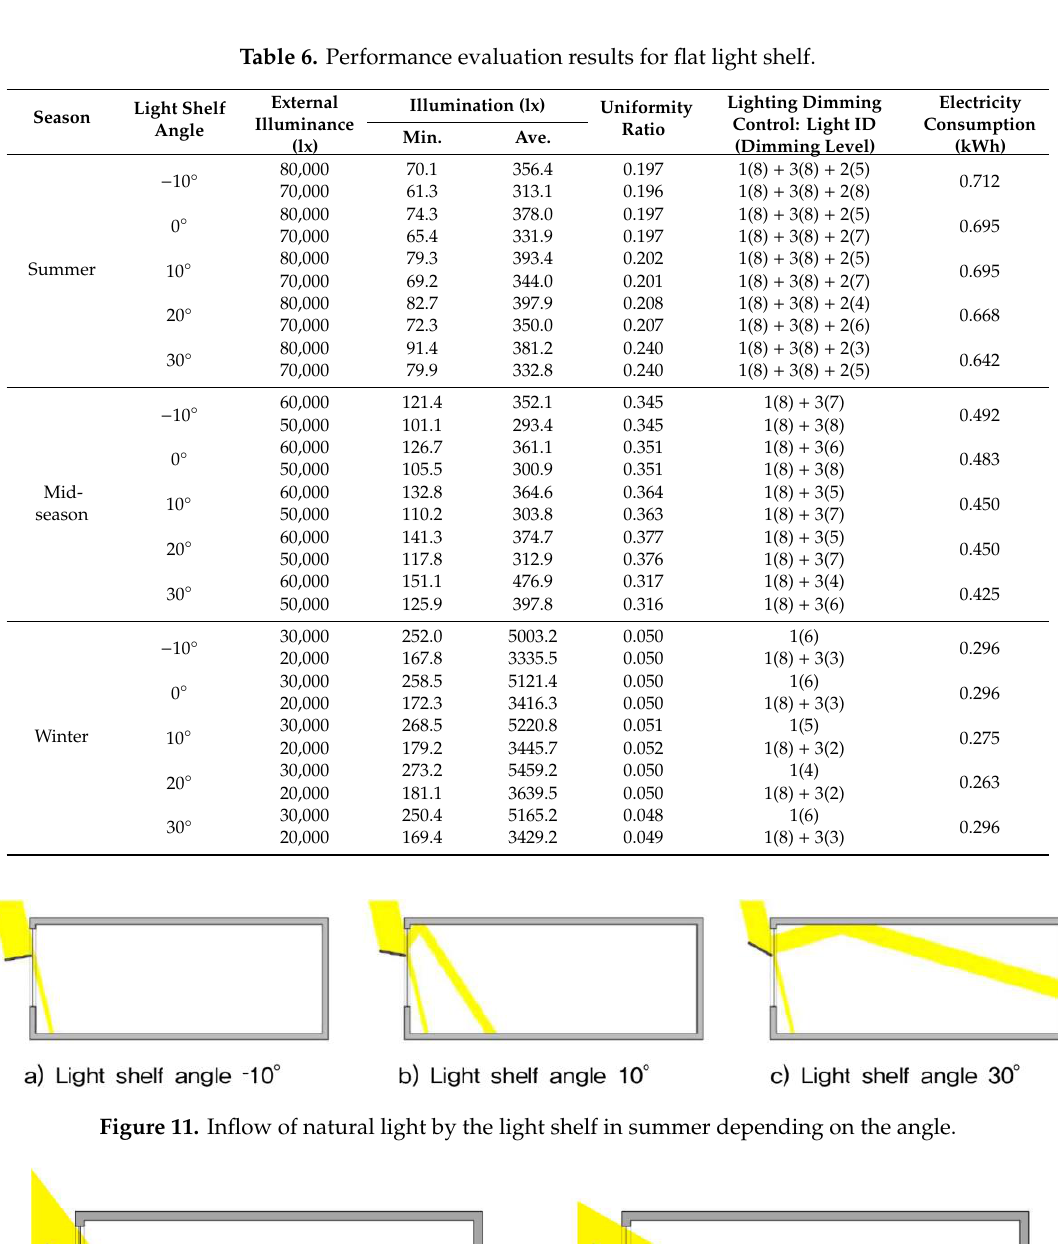
Table 6. Performance evaluation results for flat light shelf.